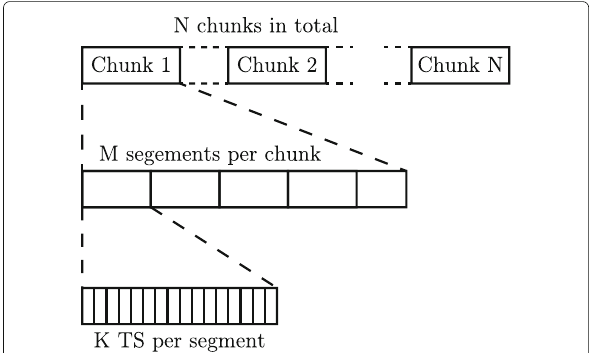
Fig. 2 The timeline structure of the Vienna 5G SL simulator. The simulation time in the simulator is divided into chunks, segments, and TSs. Chunks are processed independently and do not need any input of results from other chunks. At the beginning of each segment, MF values are updated, but are constant within one segment. A TS is the basis for scheduling and feedback